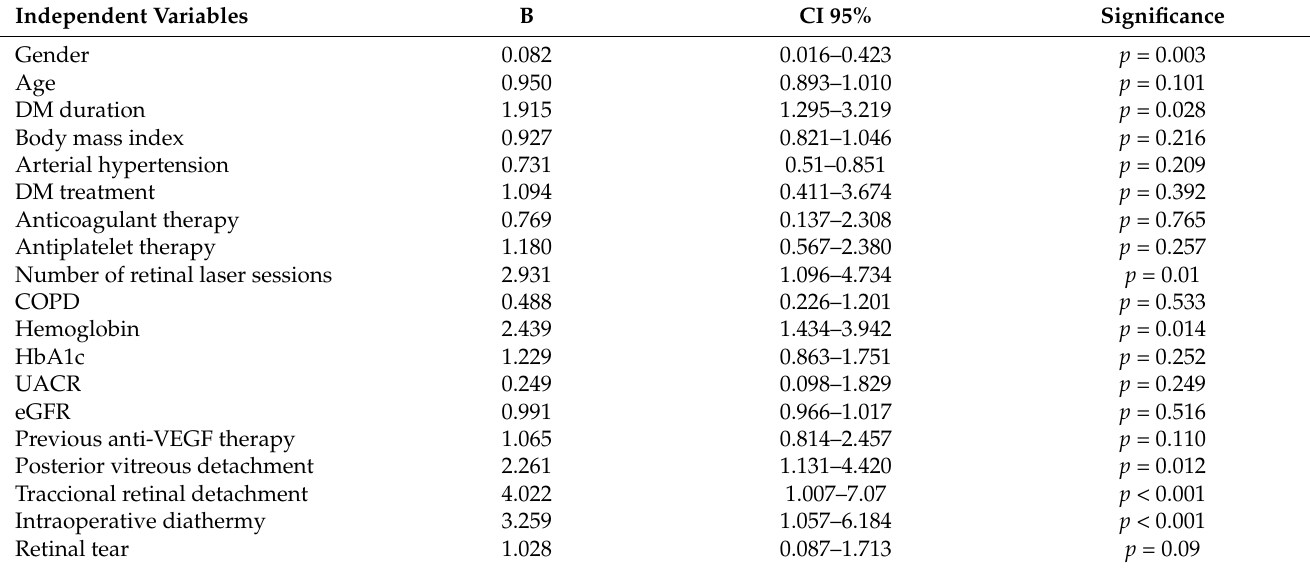
Table 2. Logistic regression study of each independent variable in relation to the recurrence of vitreous hemorrhage (RVH), assessed by means of logistic regression analysis. The gender, duration of diabetes, level of hemoglobin, presence of the posterior vitreous attached to the retina, number of retinal laser sessions before the first episode of vitreous hemorrhage, and presence of tractional retinal detachment were risk factors in our population of diabetic patients with proliferative diabetic retinopathy who showed recurrent vitreous hemorrhage. On the other hand, intraoperative diathermy significantly reduced the occurrence of RVH and was also